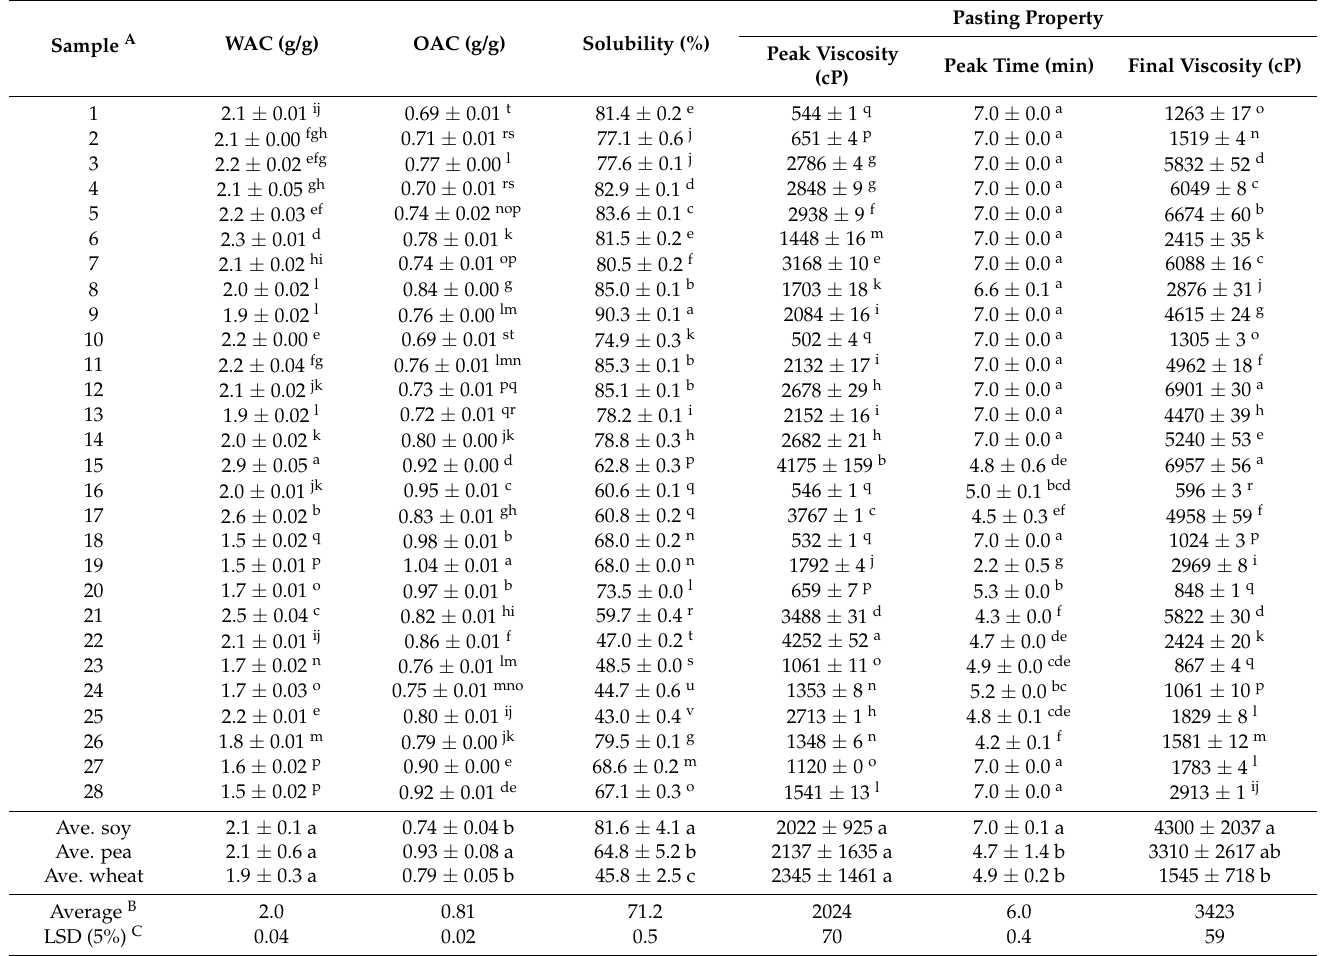
Table 3. Physicochemical properties of